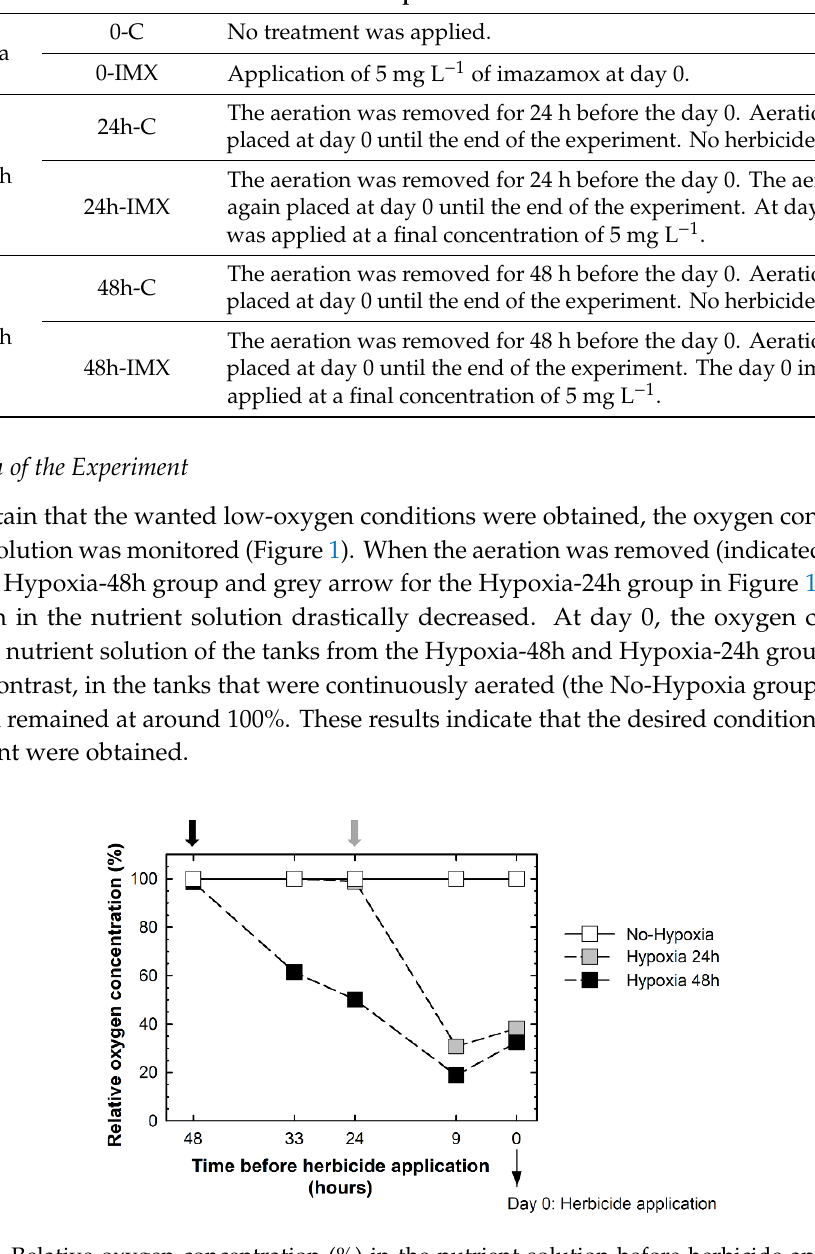
Figure 1. Relative oxygen concentration (%) in the nutrient solution before herbicide application. Black and grey arrows above the graph indicate aeration removal 48 h and 24 h before herbicide application, respectively .